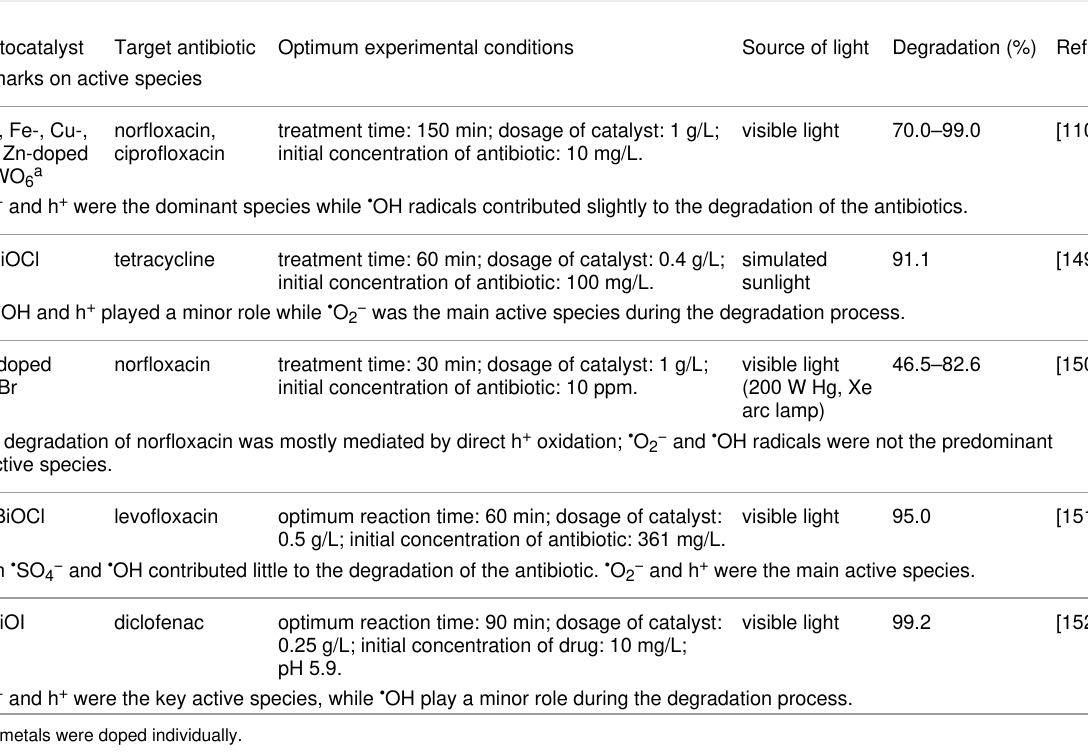
Table 6: Doped Bi-based nanostructured photocatalysts for antibiotic remediation.